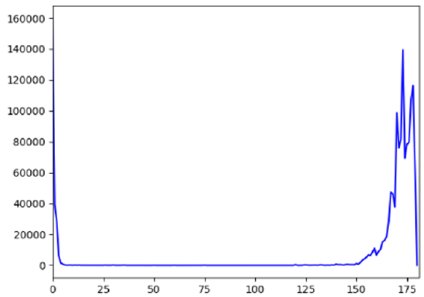
Figure 14. H-channel histogram of area occupied by tomatoes.